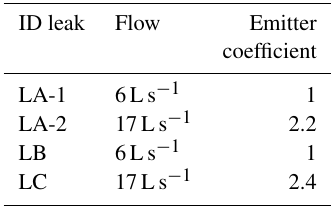
Table 4. Emitter coefficients corresponding to simulated leaks. Table 5. Quantification of the